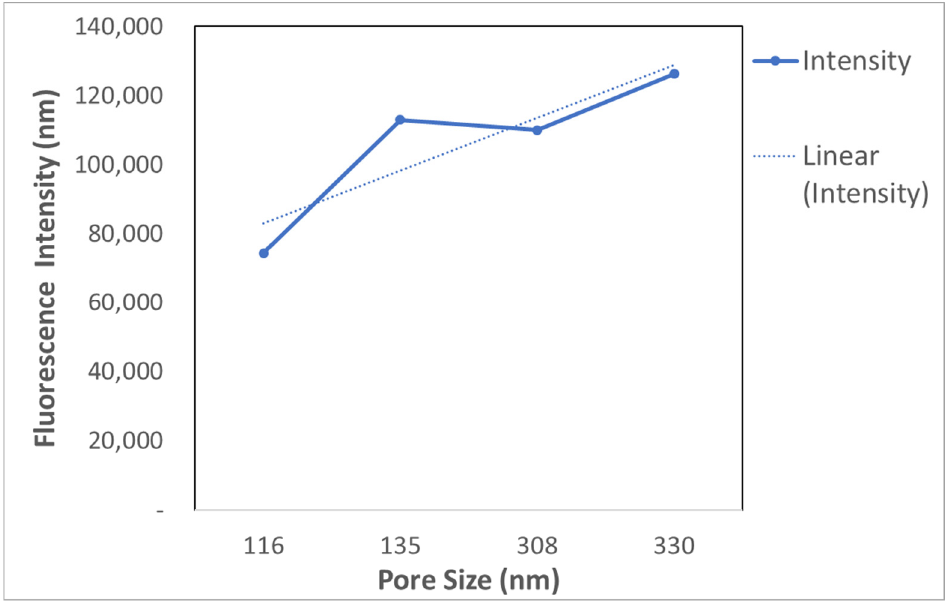
Figure 13. Pore Size vs. Fluorescence Intensity